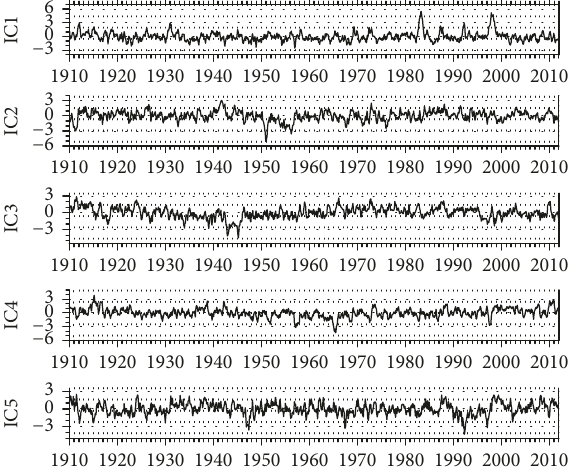
Figure 10: IC time-series for the period 1910–2011.